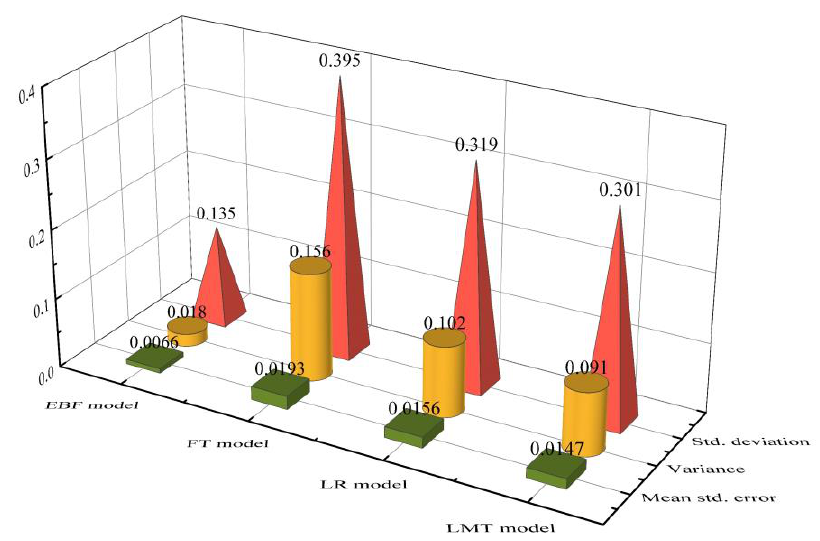
Figure 10. Target and output values for the evidential belief function (EBF) model of ( a ) training and ( b ) validation dataset samples; FT model of ( c ) training and ( d ) validation dataset samples; logistic regression (LR) model of ( e ) training and ( f ) validation dataset samples; LMT model of ( g ) training and ( h ) validation dataset samples.